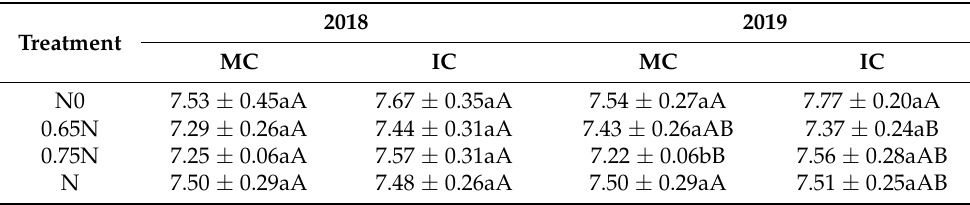
Figure 4. Effects of different treatments on soil organic matter content (%). Note: * Represents the significant difference between MC and IC at the same nitrogen dose in the same year; different capital letters indicate the difference between treatments with different nitrogen doses in the same year and the same mode; bars below letters represent standard deviation. Table 4. Effects of different treatments on soil pH.